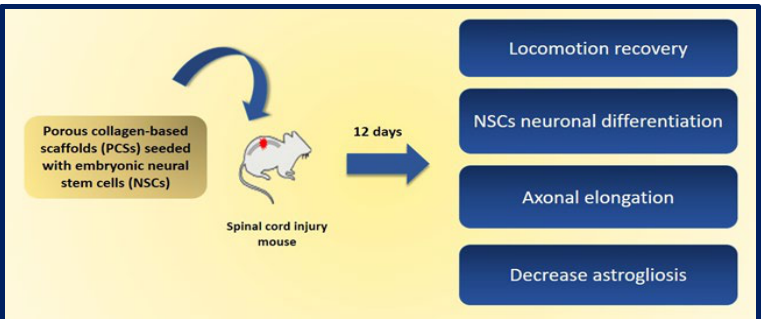
Figure 23. Graphic representation of the benefits obtained after 12 days of the implantation of porous collagen-based scaffolds (PCSs) seeded with NSCs in a murine model of spinal cord injury. Bibliography consulted [193].